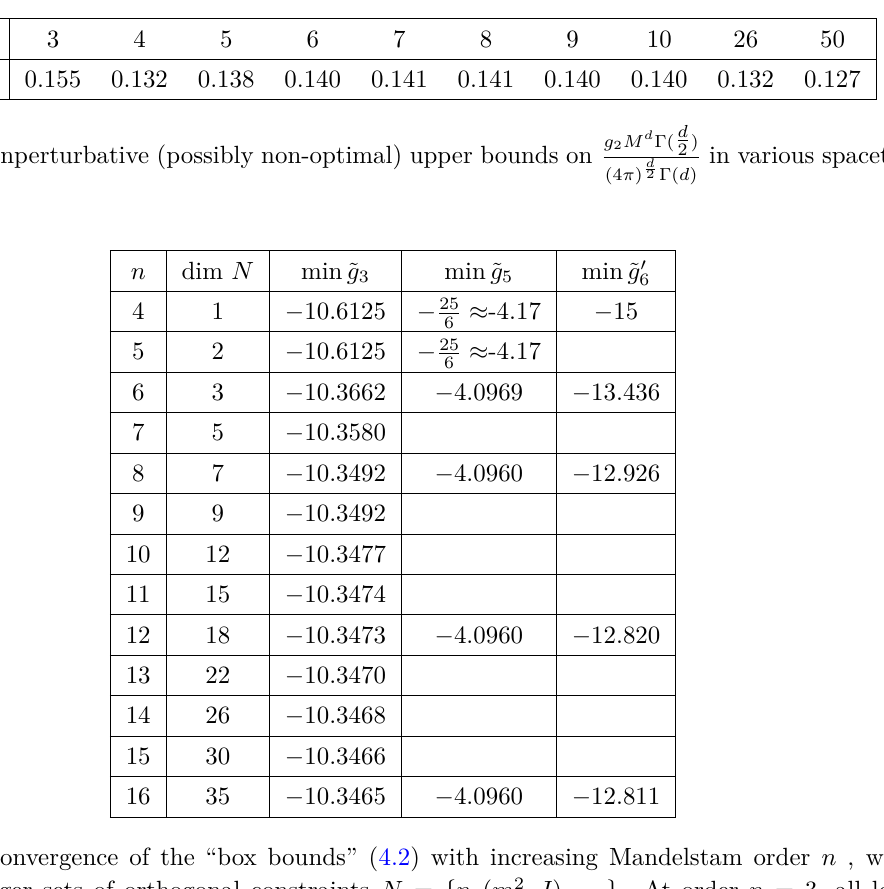
( m 2 , J ) , · · · } . At order n = 3 , all lower 4